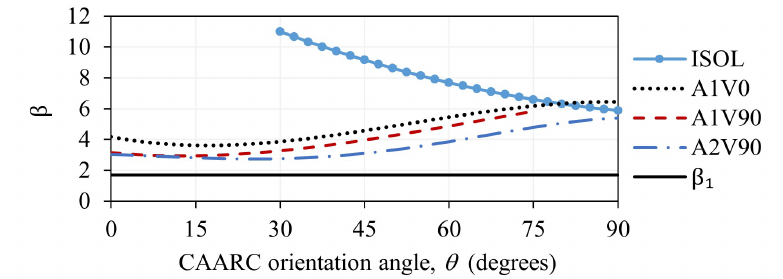
Figure 15. Reliability index β for displacement, y-direction – limit criterion of